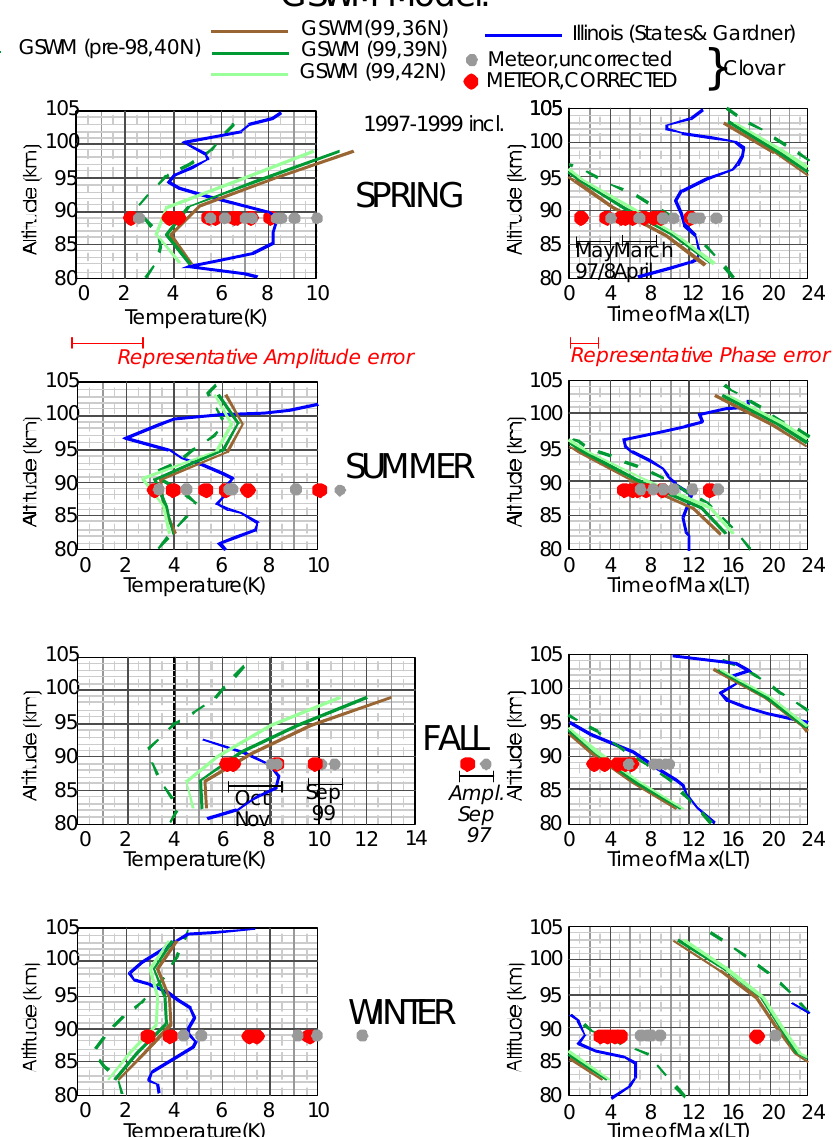
Fig. 6 Fig. 6. As for Fig. 4, but in this case the meteor data which are presented are for the Clovar meteor radar at London, Ontario (43 ◦ N). Data c:\wkh\egs\mtidef06.cdr from several years during the period 1997 to 2000 are shown. In contrast to Fig. 4, however, each month of data has been analyzed and plotted separately, in order to demonstrate the degree of variability that occurs from month-to-month and year-to-year. Note that as a rule the “uncorrected” or “naive” amplitude estimates exceed the “true” (corrected) estimates. Error bars are not given for all points, since it would clutter the diagram too much, but representative error bars are